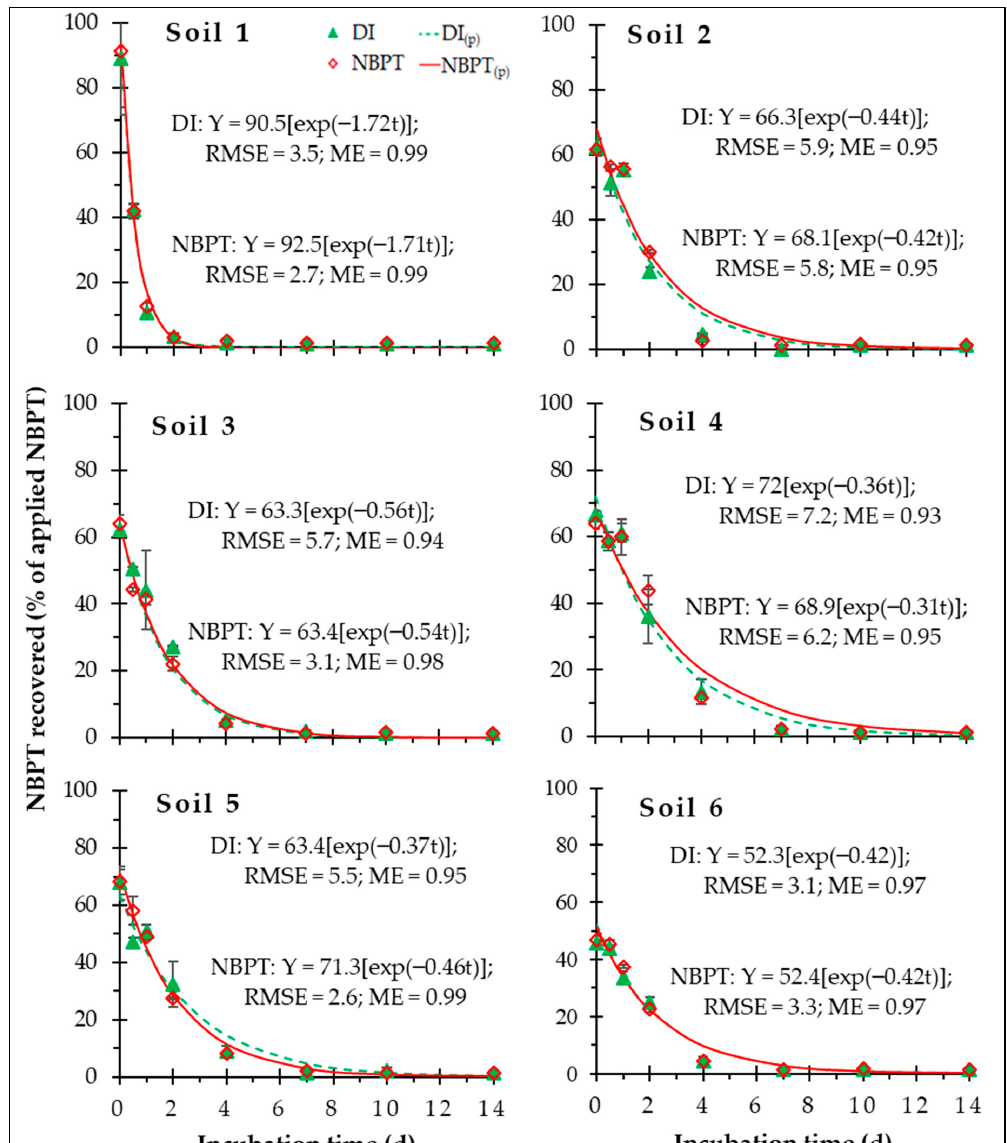
Figure 1. The percentage recovery of NBPT in soils. Error bars are standard errors of the mean ( n = 3). NBPT and NBPT(p) are measured and predicted % of NBPT recovered in NBPT inhibitor treatment; DI and DI(p) are measured and predicted % of NBPT recovered in DI inhibitor treatment. N -( n -butyl) thiophosphoric triamide; DI, double inhibitor [NBPT + 3,4-dimethyl pyrazole phosphate]; Y, % of applied NBPT recovered; RMSE, Root mean square error, ME, Nash–Sutcliffe model